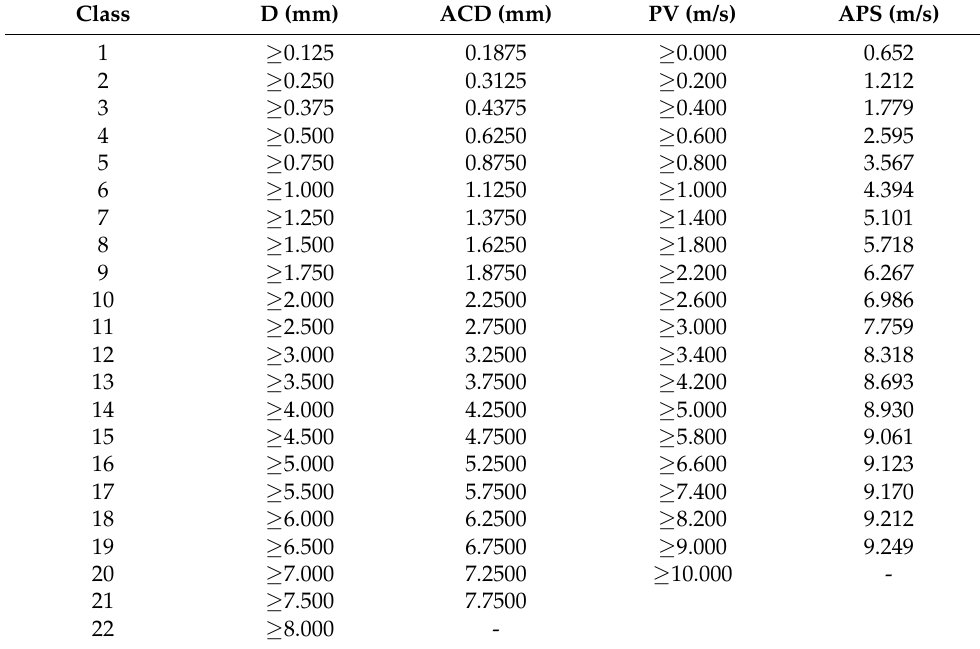
Table 1. Diameter and particle velocity classes registered in the